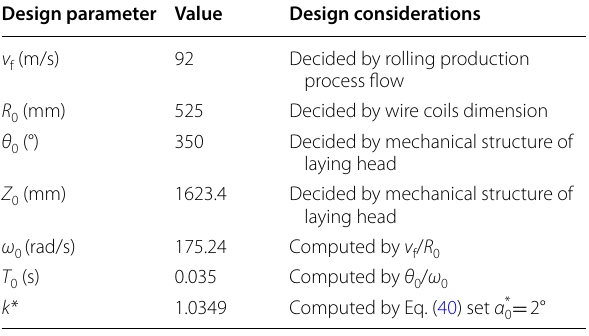
Table 1 A solution for design parameters of laying pipe Design parameter